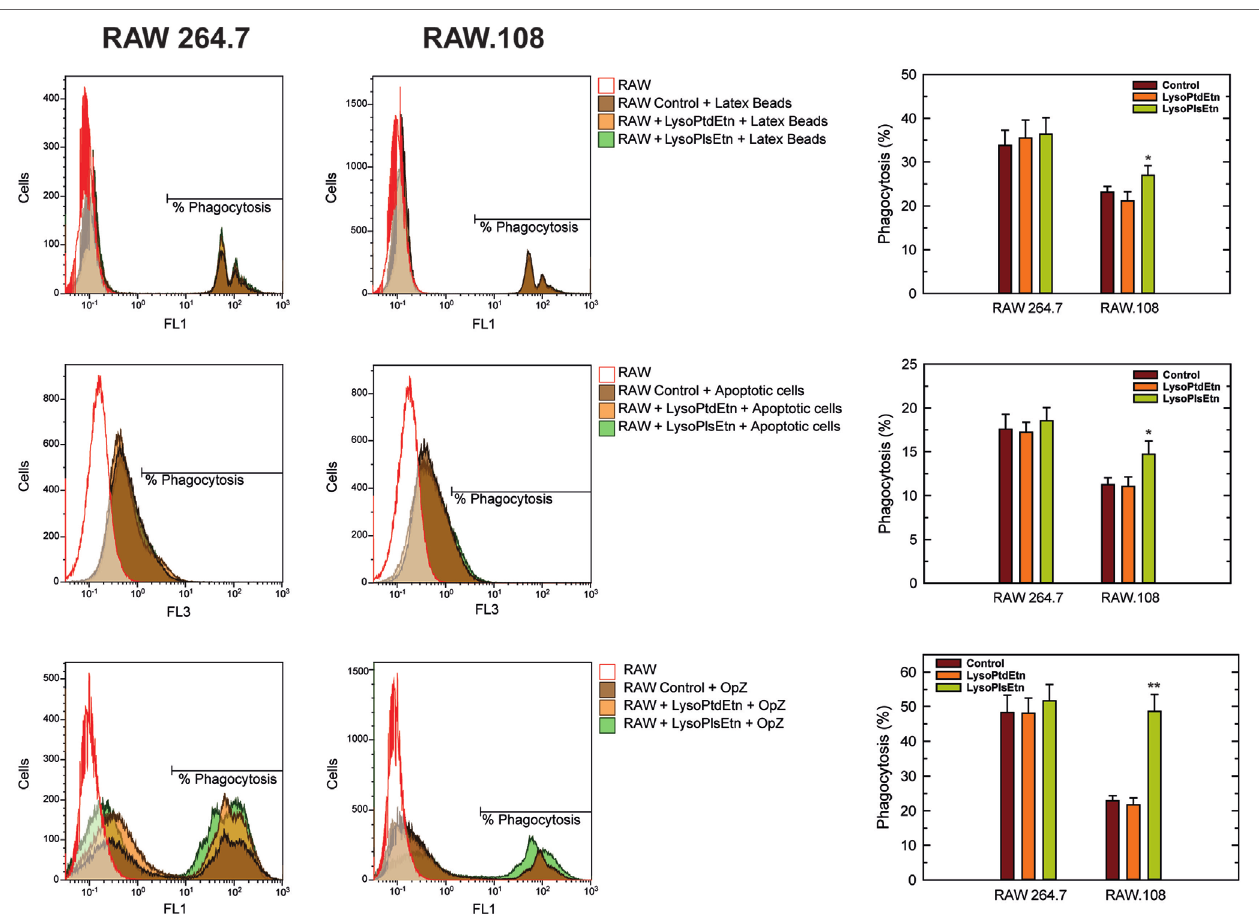
FigUre 5 | Effect of lysoPlsEtn on the phagocytosis of different targets by RAW 264.7 and plasmalogen-deficient RAW.108 cells. The cells were either untreated or treated with 10 µM lysoPlsEtn or 10 µM lysoPtdEtn for 10 min as indicated. Afterward, unopsonized latex beads (5–7 particles/cell, 30-min incubation) or apoptotic Jurkat cells (ratio 3:1, 2-h incubation) were added, and phagocytosis was analyzed by flow cytometry. Measurements run in parallel using opsonized zymosan particles (OpZ, 5–7 particles/cell) are also shown for direct comparison. *Significantly different ( p < 0.05) from untreated cells; **significantly different ( p < 0.01) from untreated